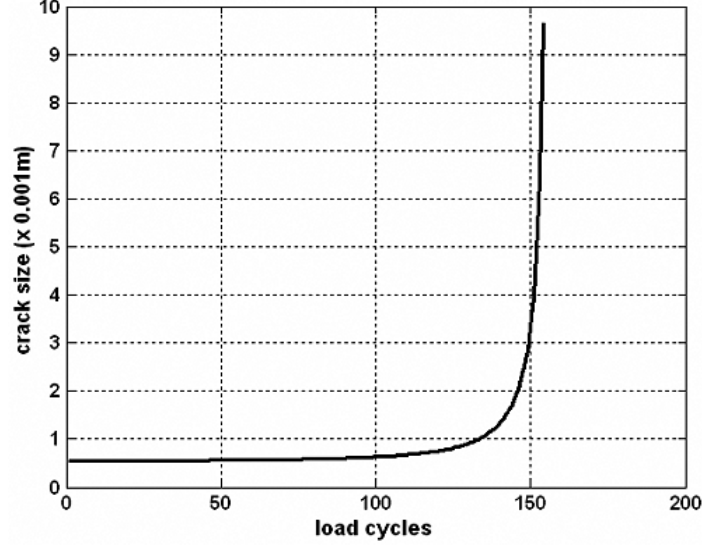
Fig. 6. Crack propagation along load cycles.